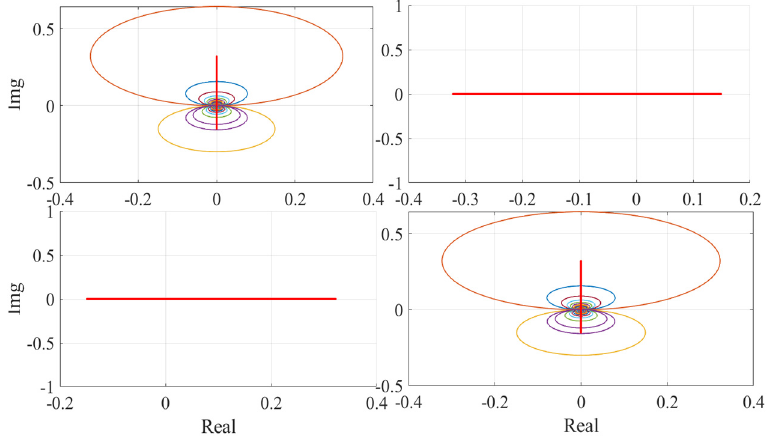
Figure 4. Gershgorin band graph of transfer function (16) with the parameter values of Table 3. Table 2. Effect of the control parameter on PM and bandwidth of the current control loop. Table 3. The test system